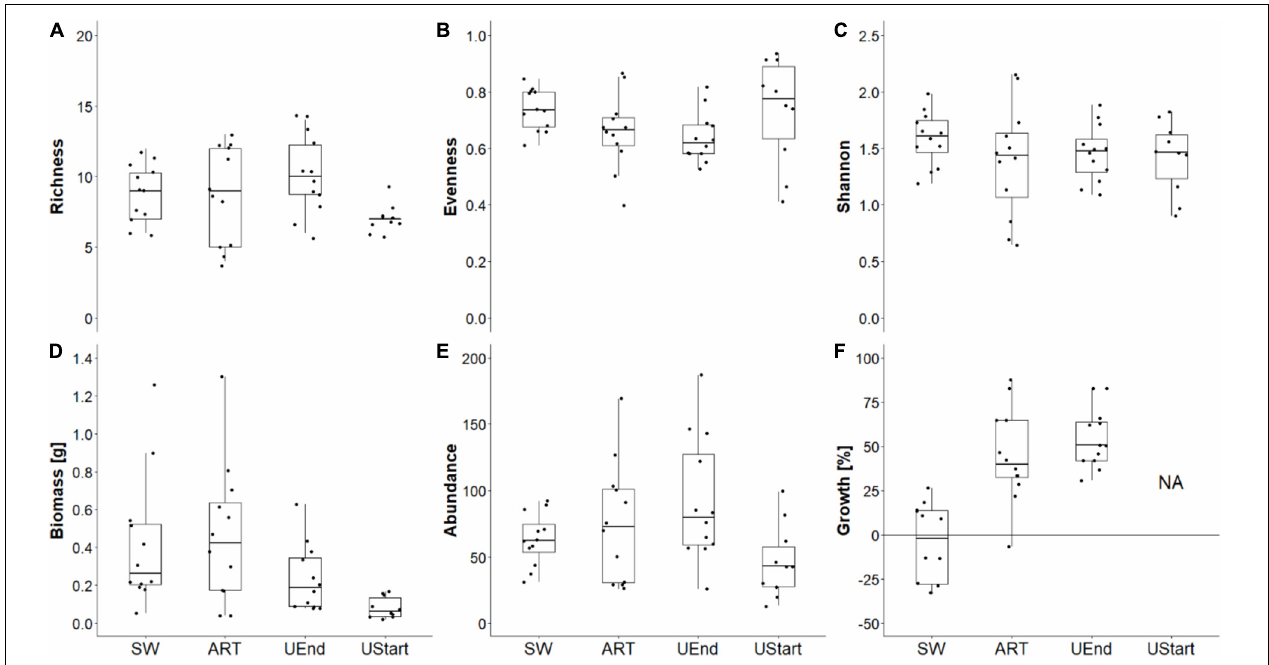
FIGURE 6 | Thiisbukta. Median (thick horizontal line) ± SEM (box), 95% confidence interval (vertical line), and sample-wise values (points) of taxon richness (A) , evenness (B) , Shannon-index (C) , biomass (D) , abundance (E) , and growth (F) of the benthic fauna in core samples (21 cm 2 surface area) taken in seaweed-covered (SW), procedural controls (ART), unmanipulated areas at end (UEnd) and unmanipulated area at start (UStart). For growth, “NA” = data not available for areas unmanipulated at start. n = 12. TABLE 4 | Summary of PERMANOVA results based on 9999 permutations of Bray–Curtis similarities calculated of relative abundances of taxa. Mixed model two-way analyses (seaweed effect and artifact) were reanalyzed if the respective treatment × block interaction showed p ≥ 0.25, by pooling residual variance and that of the interaction term of the full model. Longyearbyen Thiisbukta Source of